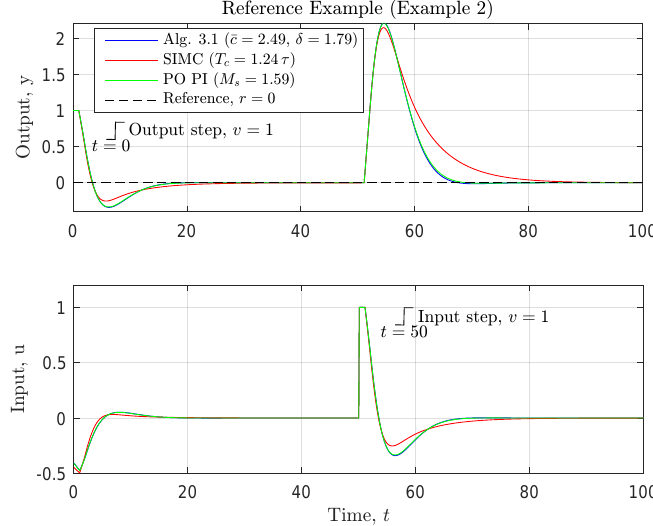
Figure 5. Example 2 (Reference example). Consider PI control of an IPTD process model, H p ( s ) = e − s